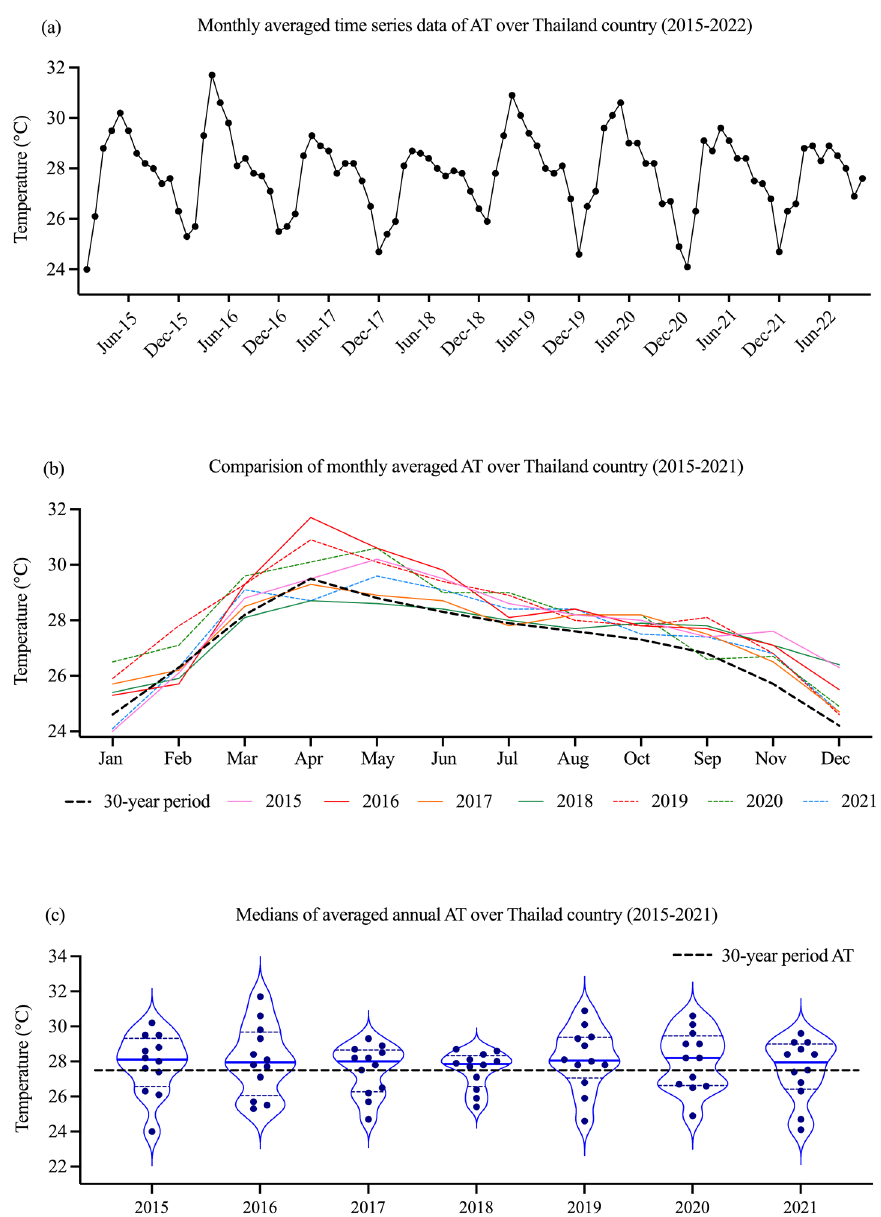
Figure 2. The monthly averaged time series of AT ( a ), the comparison of monthly averaged AT ( b ), and the violin plot of averaged annual AT ( c ) over Thailand during 2015–2022 and 30-year period. For each violin plot, the bold horizontal line in the center of the box represents the median, and the dash lines at the bottom and top of the box represent the first and third quartiles, respectively. AT; air temperature.